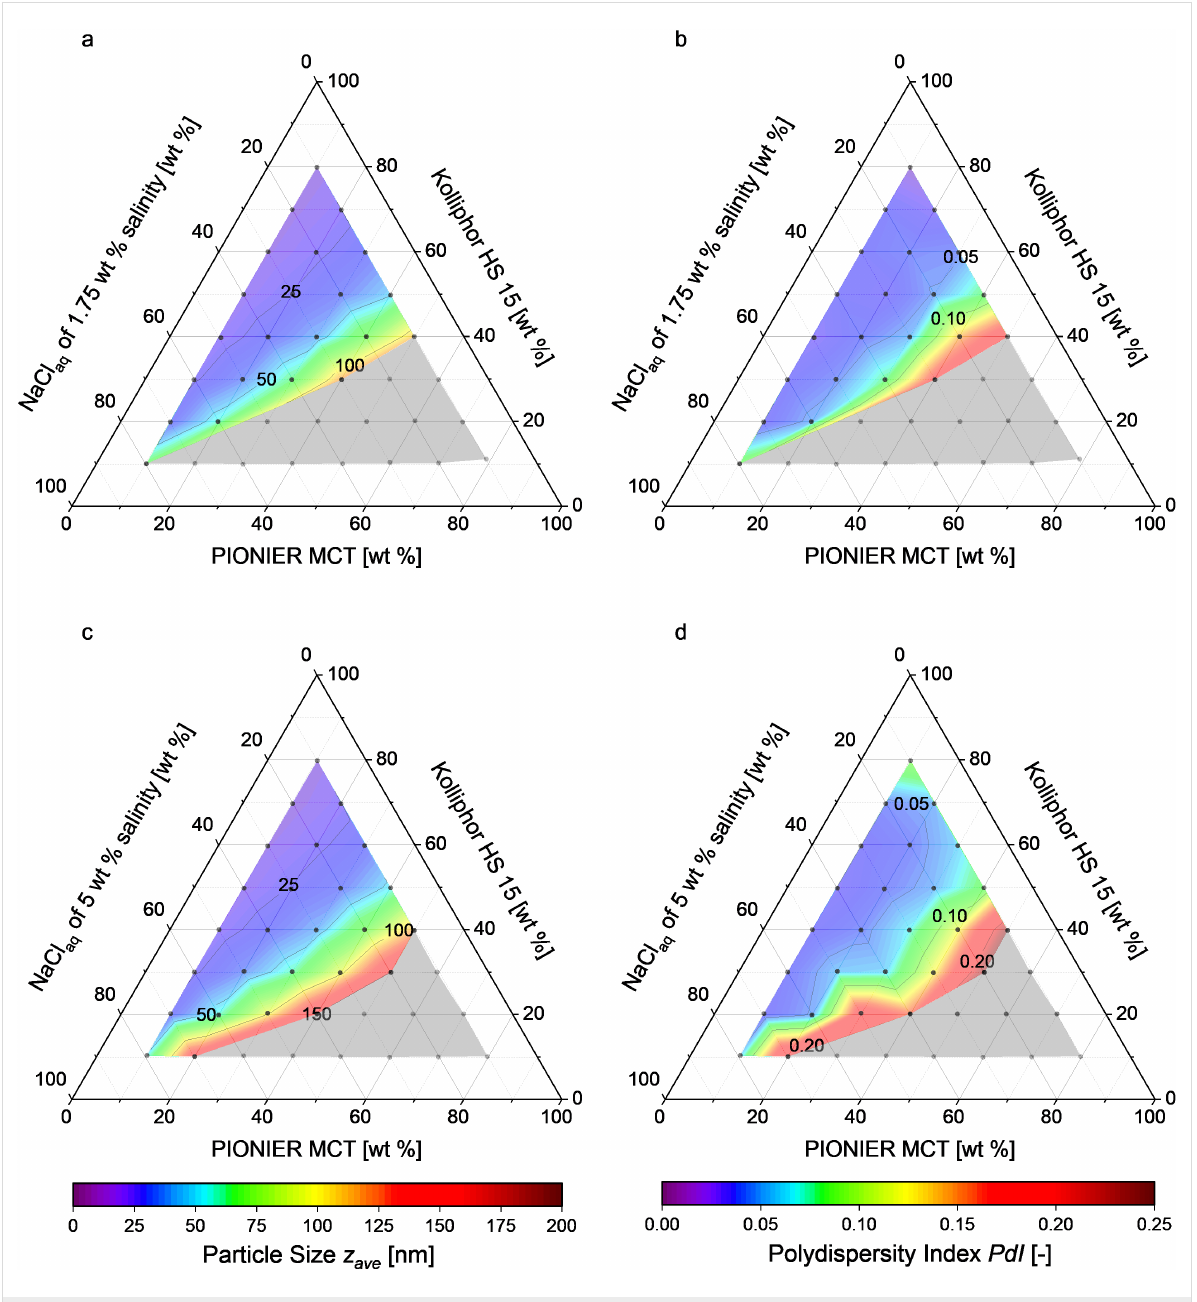
Figure 2: Ternary phase diagrams giving the particle diameter and the PDI of the nonisotonic nanoemulsions produced in (a, b) 1.75 wt % and (c, d) 5 wt % NaCl aqueous solution. Each dot represents the composition of the solution prepared for shock dilution. Formation of stable nanoemul- sions occurs in the colored zone. Creaming coalescence or no phase inversion were observed in the grey